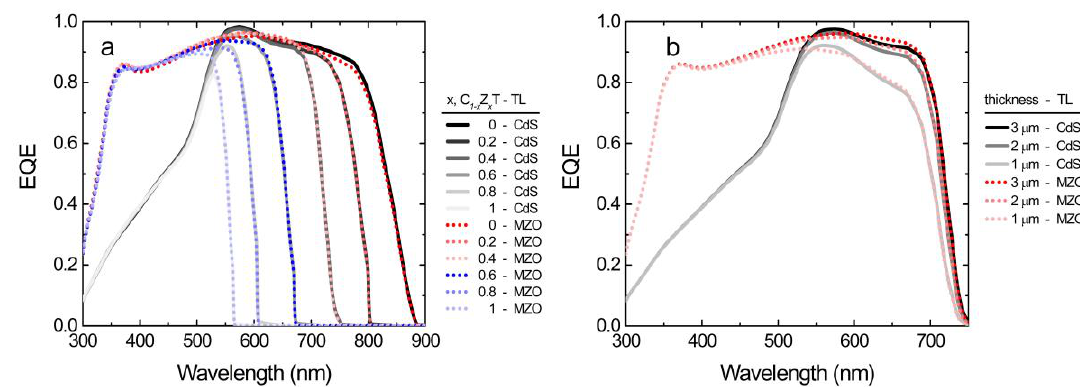
Figure 7. Calculated external quantum e ffi ciency (EQE) spectra for the C 1 − x Z x T top cell as function of ( a ) the absorber composition (x = 0, 0.2, 0.4, 0.6, 0.8, and 1) at 3 µ m thickness and ( b ) the absorber thickness (1, 2, and 3 µ m) at x = 0.6 for with 50 nm ETL of CdS and